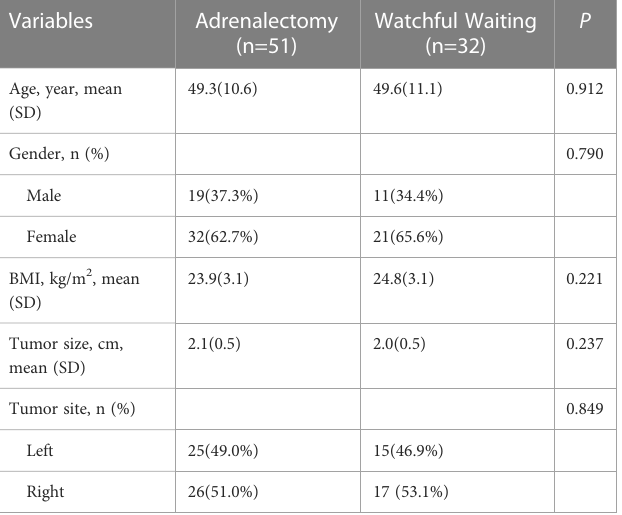
TABLE 1 Baseline demographical and clinicopathological characteristics of patients. Variables